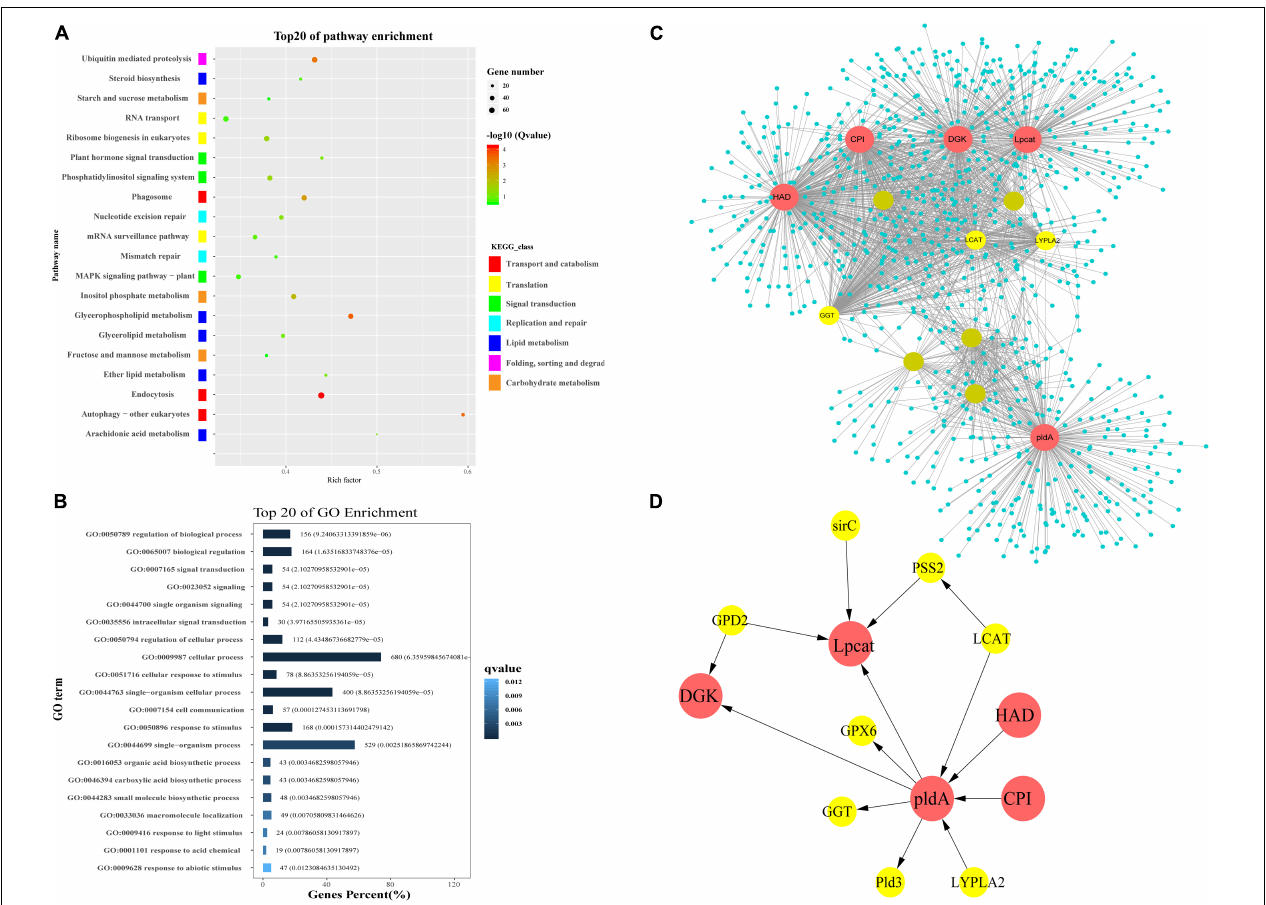
FIGURE 4 | Functional enrichment analysis and network construction of turquoise module. (A) Top 20 KEGG pathways enriched with genes in turquoise module. (B) Top 20 GO subcategories enriched with genes in turquoise module. (C) Network for lipid metabolism in turquoise module. Network was constructed by extracting turquoise genes annotated with lipid metabolism as seed nodes, with an edge weight cut-off of 0.7. Red dots indicate hub genes in the network; yellow dots indicate nodes with connectivity of at least 50. Node size represents level of connectivity. (D) Co-expression network for hub genes in lipid metabolism and candidate hub-interacting genes. Sub-network was built by extracting hub genes and the selected candidate co-expressed genes connected to more than one hub genes within the lipid metabolism network. HAD, haloacid dehalogenase; DGK, diacylglycerol kinase; pldA, phospholipase D; Lpcat, lysophospholipid acyltransferase; CPI, cyclopropyl isomerase; LCAT, lecithin-cholesterol acyltransferase; GGT, gamma-glutamyl transferase; LYPLA2, lysophospholipase 2; PSS2, CDP-diacylglycerol-serine O -phosphatidyltransferase; GPD2, glycerol-3-phosphate dehydrogenase; GPX, glutathione peroxidase; Pld3, phospholipase d y-like protein; sirC, cytokinin